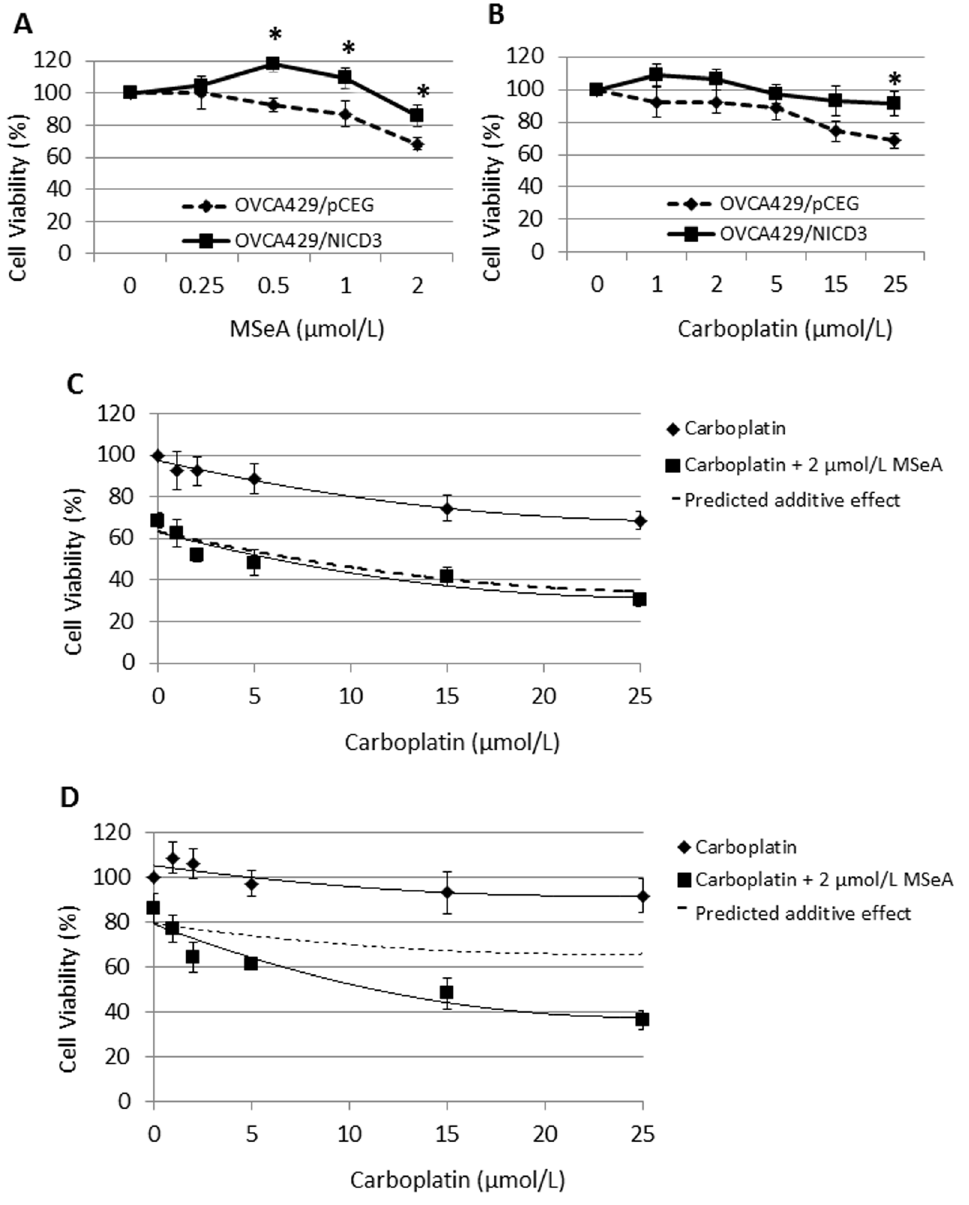
Figure 1. Synergistic effect of MSeA and carboplatin on the killing of OVCA429/NICD3 cells. OVCA429/pCEG and OVCA429/NICD3 cancer cells were treated with a gradient concentration of MSeA ( A ) or carboplatin ( B ) for 2 days. *, p , 0.05, compare to OVCA429/pCEG cells. OVCA429/ pCEG cells ( C ) and OVCA429/NICD3 cells ( D ) were treated with carboplatin (0–25 m mol/L) in the absence or presence of MSeA (2 m mol/L) for 2 days. Values are mean 6 S.E.M. (n = 3). Dashed lines predict the additive effect of MSeA and carboplatin.